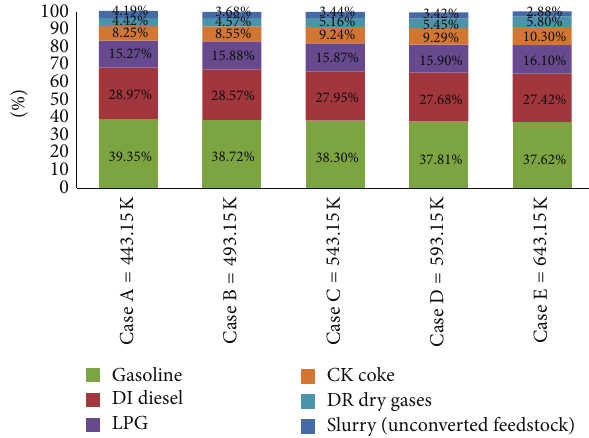
Figure 8: Temperature profiles for the axial plane with variation feedstock temperature.